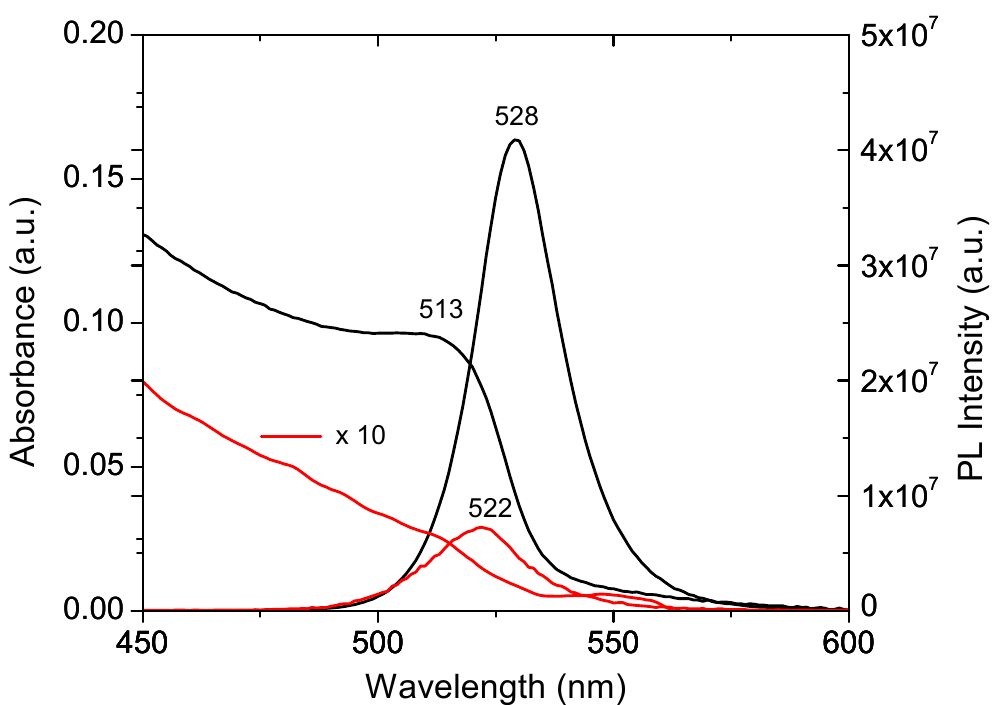
Figure 6. ( a) Fluorescence emission spectra of thin-films ( TFa ), ( TFb ), ( TFc ), ( TFd ) on day 1 (black line) and day 11 (red line).